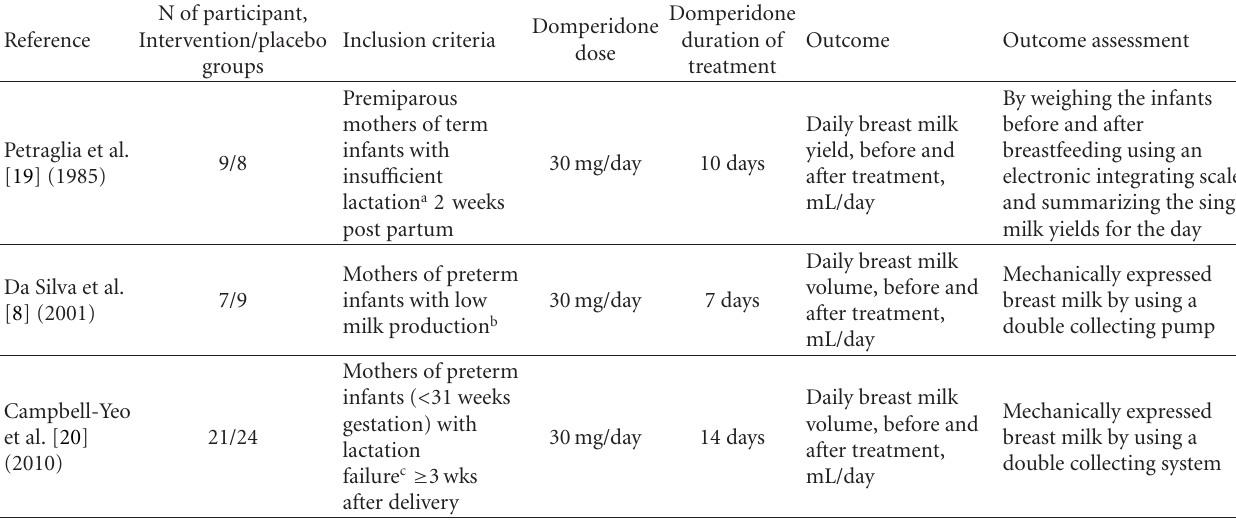
Table 1: Characteristics of trials included in analysis.